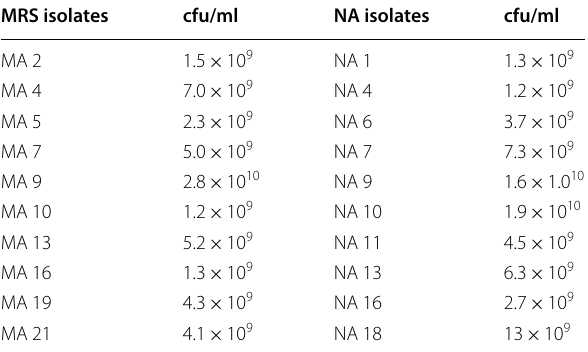
Table 1 Results of microbial growth in minimum medium